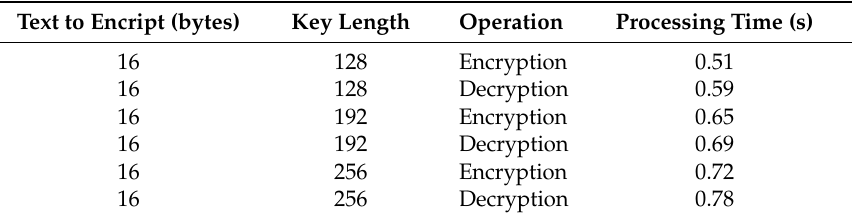
Table 1. AES Processing time with Arduino